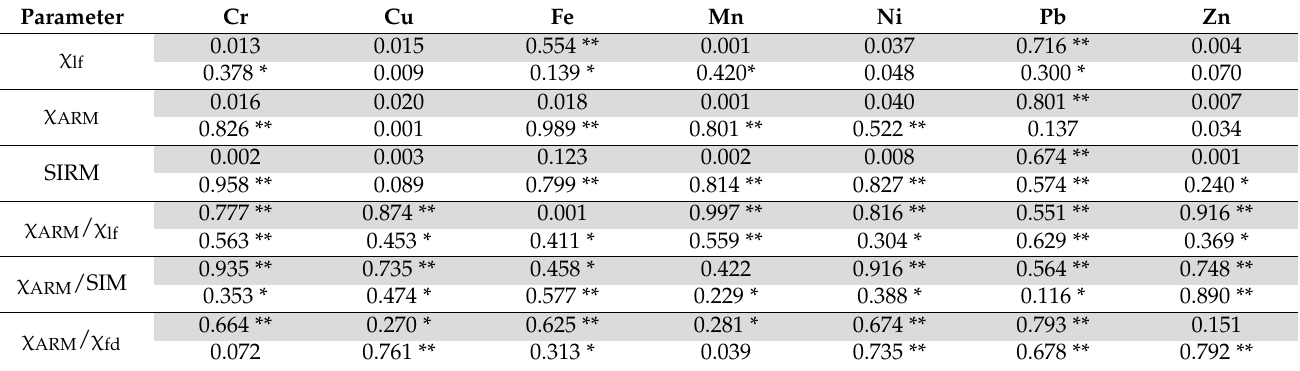
Table 4. Summary of Spearman coefficients of metal and magnetic parameters (N =